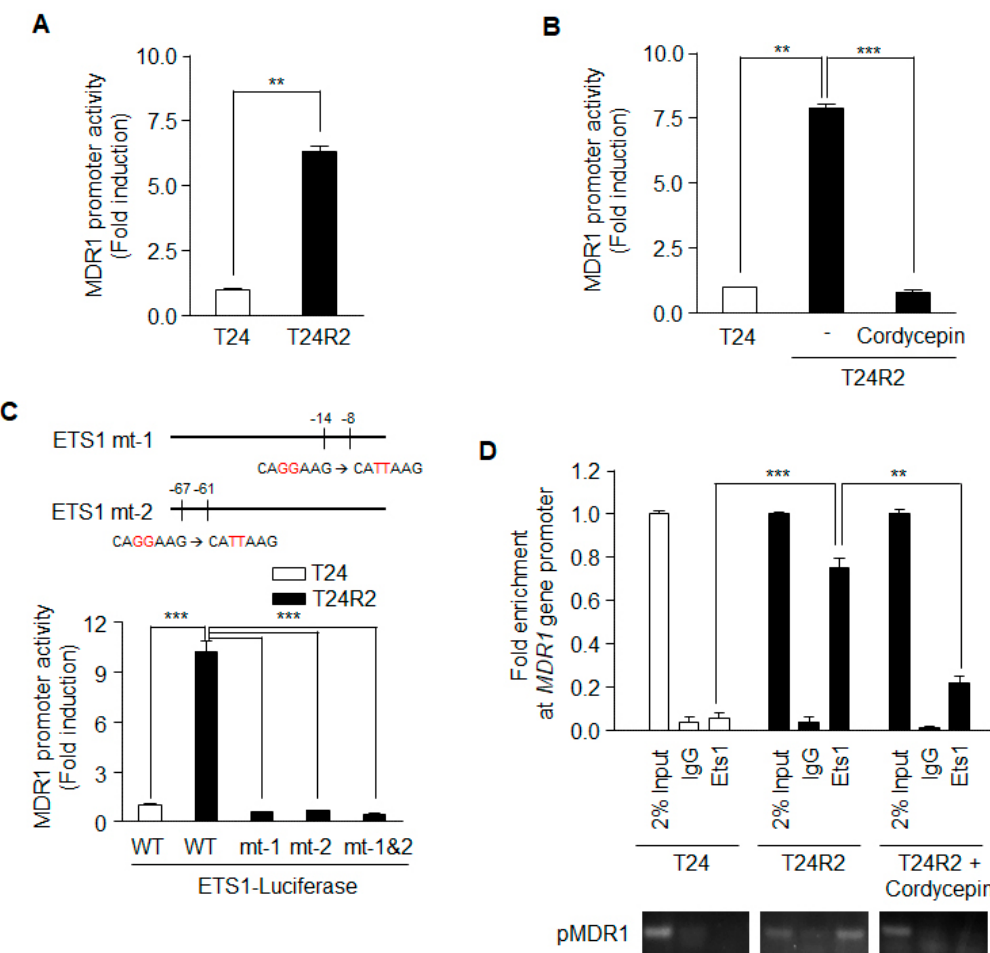
Figure 4. Ets ‐ 1 activity on the MDR1 promoter in T24R2 cells is attenuated by cordycepin treatment. T24 and T24R2 cells were transiently transfected with a pGL3 ‐ MDR1 luciferase vector that contained the 5’ ‐ promoter region of the MDR1 gene (873 bps: from − 751 to +122), and luciferase activity was determined from on the basis of the cell lysates treated without ( A ) or with ( B ) cordycepin. ( C ) Site ‐ directed mutagenesis was performed at Ets ‐ 1 biding sites (mt ‐ 1, mt ‐ 2, or mt ‐ 1 & 2) on the MDR1 promoter. pGL3 containing the wild ‐ type (WT) MDR1 promoter or one of the site ‐ mutated